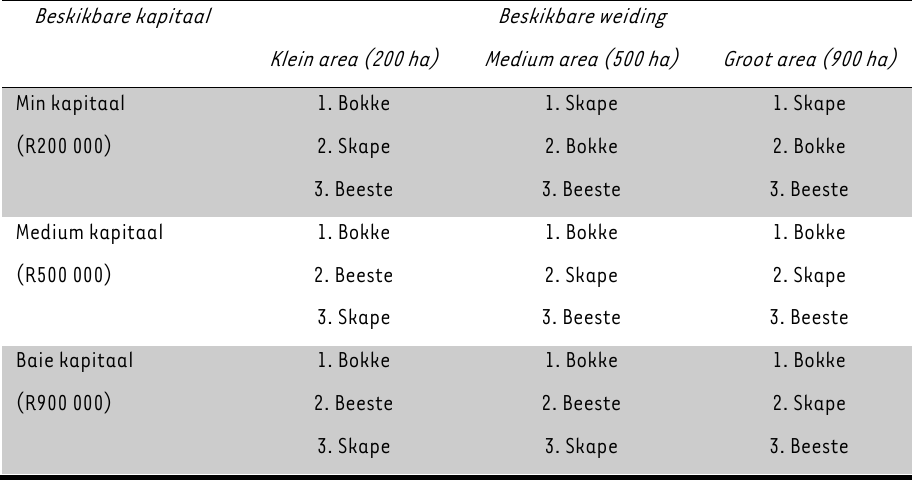
Matriks van beskikbare kapitaal en beskikbare weidingsoppervlakte Beskikbare